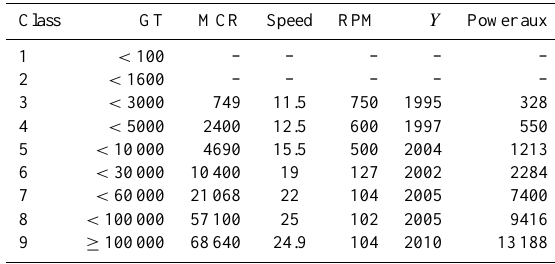
Table A1. Class medians for cargo ships.